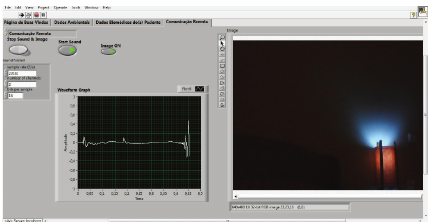
Figure 11: XBee shield placed on the plate E-Health and the set on the Arduino (adapted from [12]).